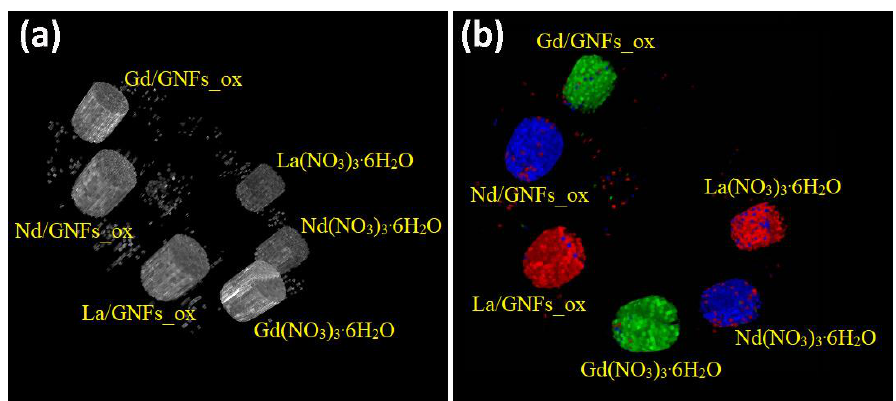
Figure 10. The 3D CT images of phantom with Ln/GNFs_ox ( a ) and color division of La/GNFs_ox (red), Nd/GNFs_ox (blue), and Gd/GNFs_ox (green) according to criteria ( b ).